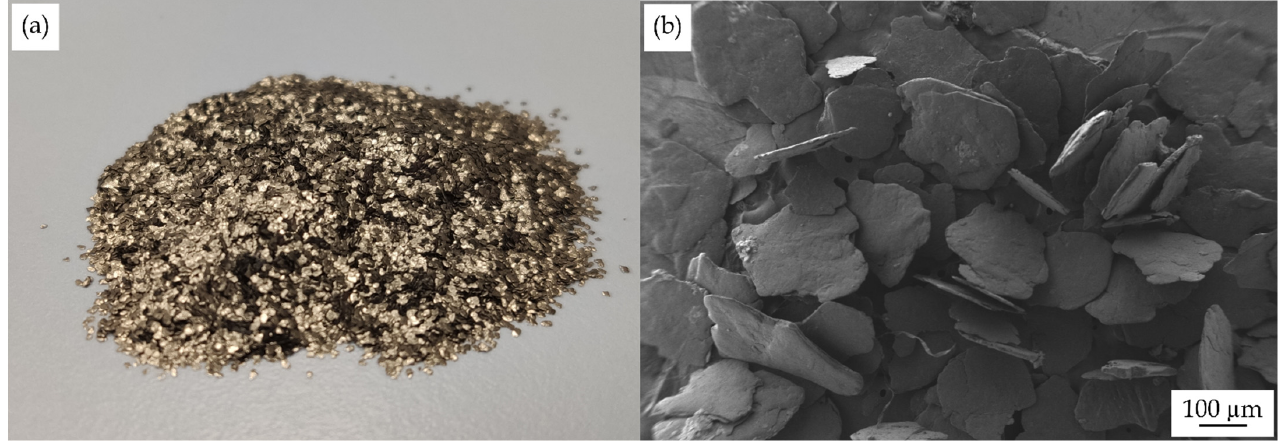
Figure 1. ( a ) Visual aspect and ( b ) field emission scanning electron microscopy (FESEM) images at 30× expandable